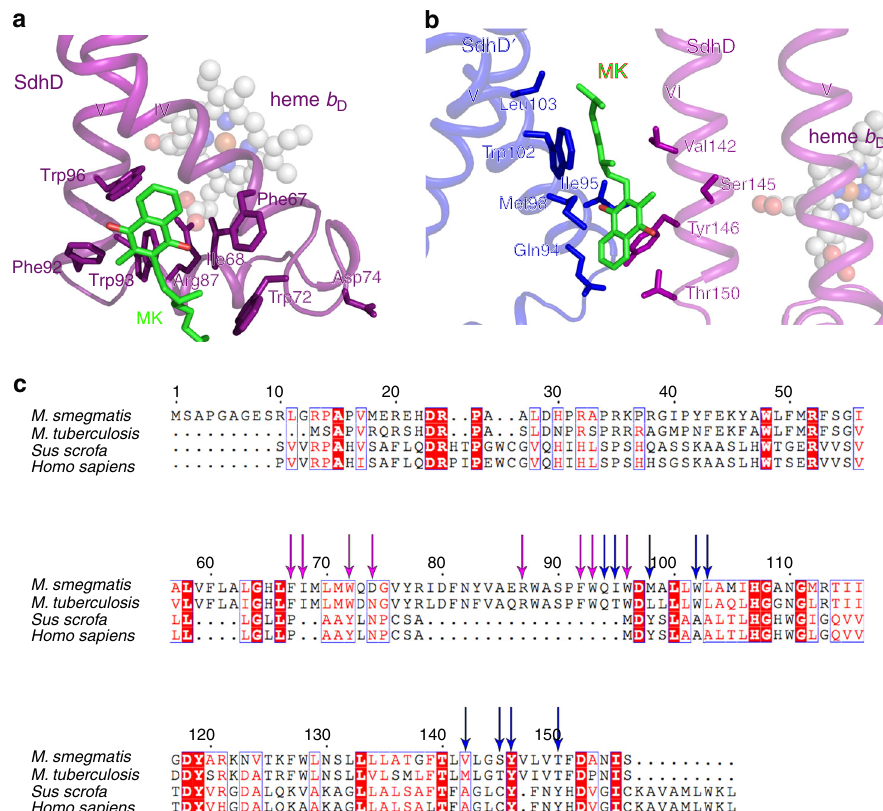
Fig. 3 Quinone binding sites analysis in M. smegmatis Sdh2 trimer. a Close-up views of Q D1 binding site. The heme b P nearby is shown in spheres. b Close-up views of Q D2 located between two neighboring SdhD subunits. c Sequence alignments of the SdhD subunits from M. smegmatis , M. tuberculosis , Sus scrofa , and Homo sapiens . Residues corresponding to Q D1 site and to Q D2 site are labeled with purple and blue arrows,